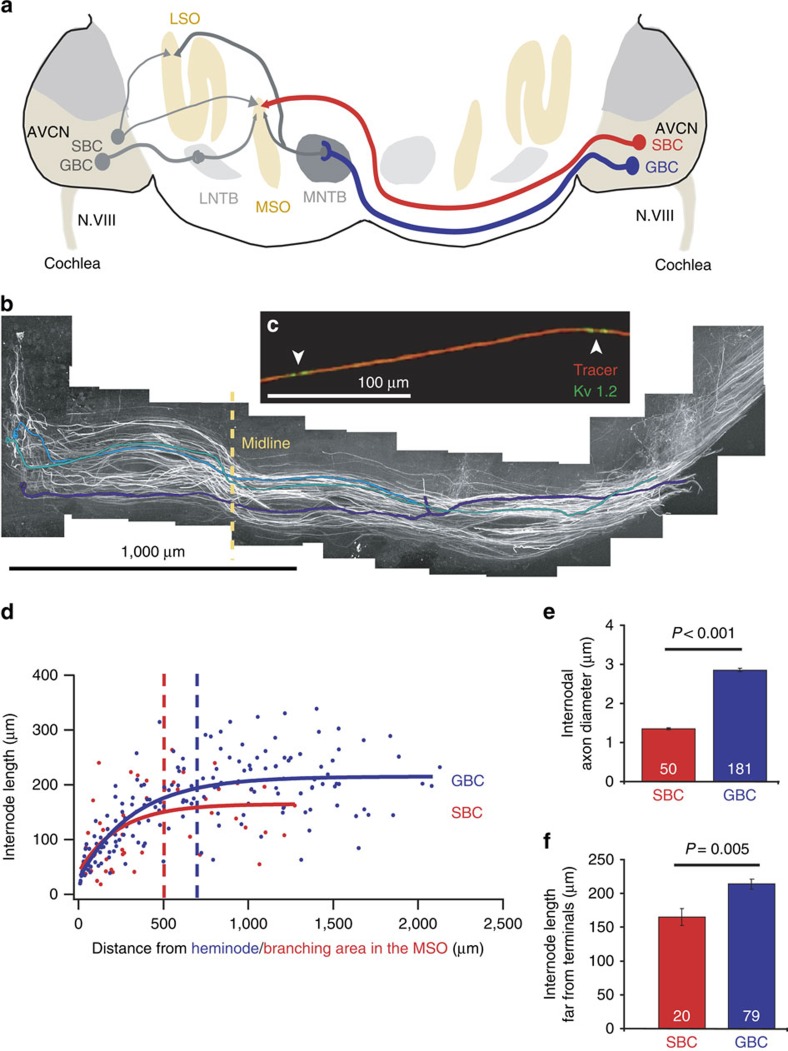
Afferent inputs to coincidence detection neurons of the MSO and LSO.(a) Simplified schematic of the mammalian ITD- and ILD-detection circuit. (b) Aligned projections of confocal image stacks from transverse brainstem slices at the level of the trapezoid body. GBC axons were anterogradely traced with tetramethylrhodamine dextran. Three individual fibres are highlighted in colour. (c) Magnification of a GBC axon segment (red) including two nodes of Ranvier (arrowheads). The position of juxtaparanodal immunolabelled Kv1.2 channels is shown in green. (d) Internode length in GBC and SBC axons plotted against the distance from the heminode and the branching area in the MSO, respectively. (e) The mean internodal axon diameter is significantly larger in GBC axons than in SBC axons (P<0.001; Mann–Whitney test). (f) The mean internode length is larger in GBC axons than in SBC axons (P=0.005, t-test). For GBC and SBC axons, the mean INL was calculated from internodes located >700 μm away from the heminode and from internodes located >500 μm away from the MSO, respectively (dashed lines in d). Numbers on bars are of internodes in 17 GBC and 7 SBC axons. Data in e,f are represented as mean±s.e.m. Scale bars, 1,000 μm (b) and 100 μm (c).